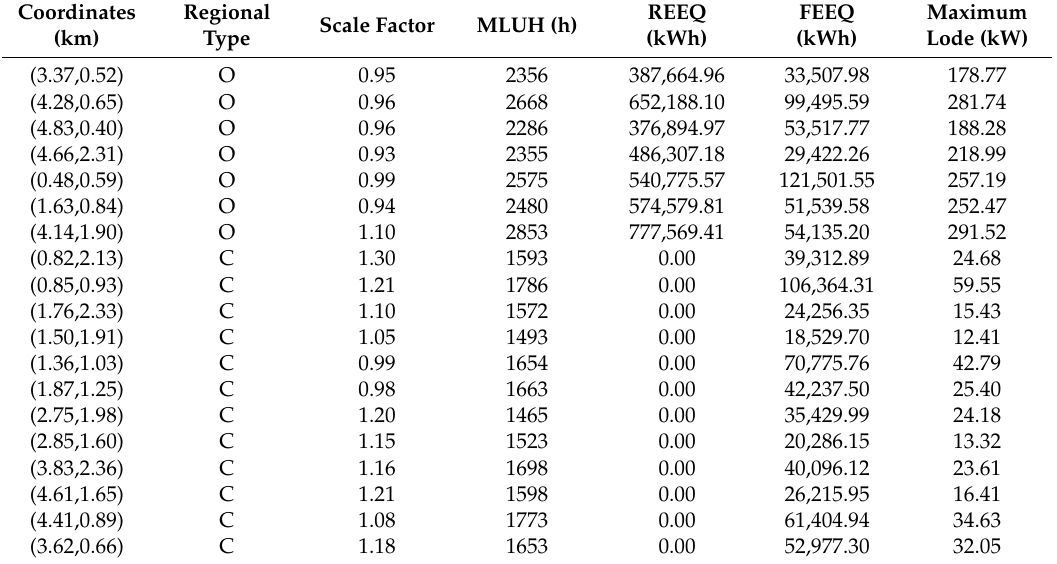
each gas station.